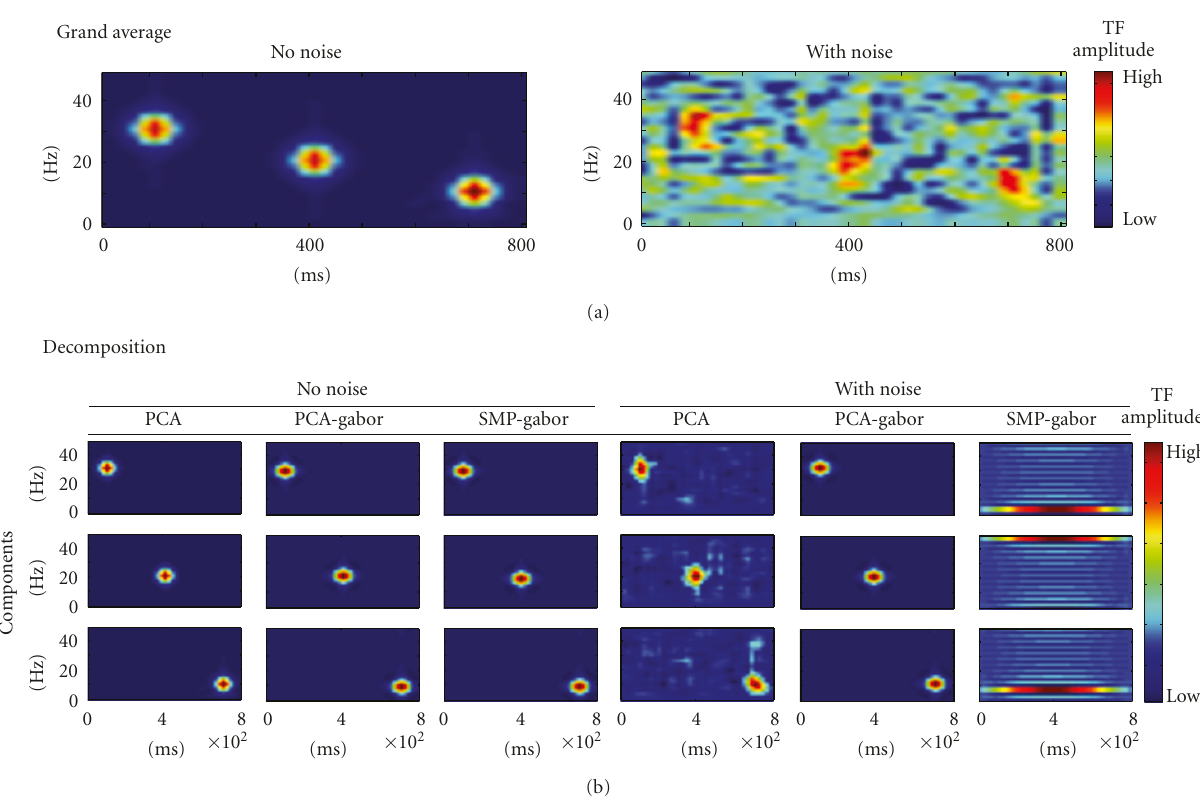
Figure 1: A comparison of the principal components (PCA), Gabor logons extracted from the principal components (PCA-Gabor) and Gabor logons extracted by Simultaneous Matching Pursuit using a Gabor dictionary (SMP-Gabor) from two simulated datasets (3-logons with no noise and 3-logons with noise).